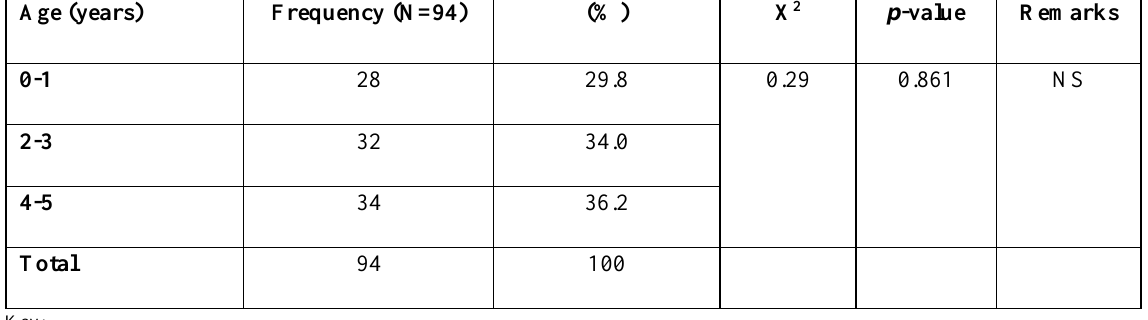
Table 3. Age distribution of astrovirus among children in Offa.